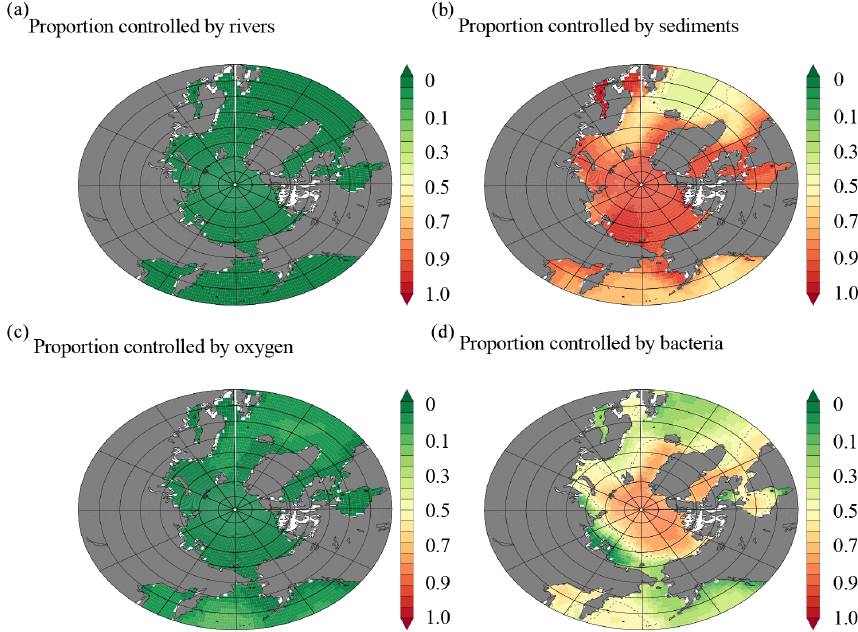
Figure 9. (a) Model output of the proportion of the dCo signal from 0 to 50m that is controlled by (a) rivers, (b) sediment input, (c) oxygen concentrations, and (d) removal by Mn oxidation from Mn-oxidizing